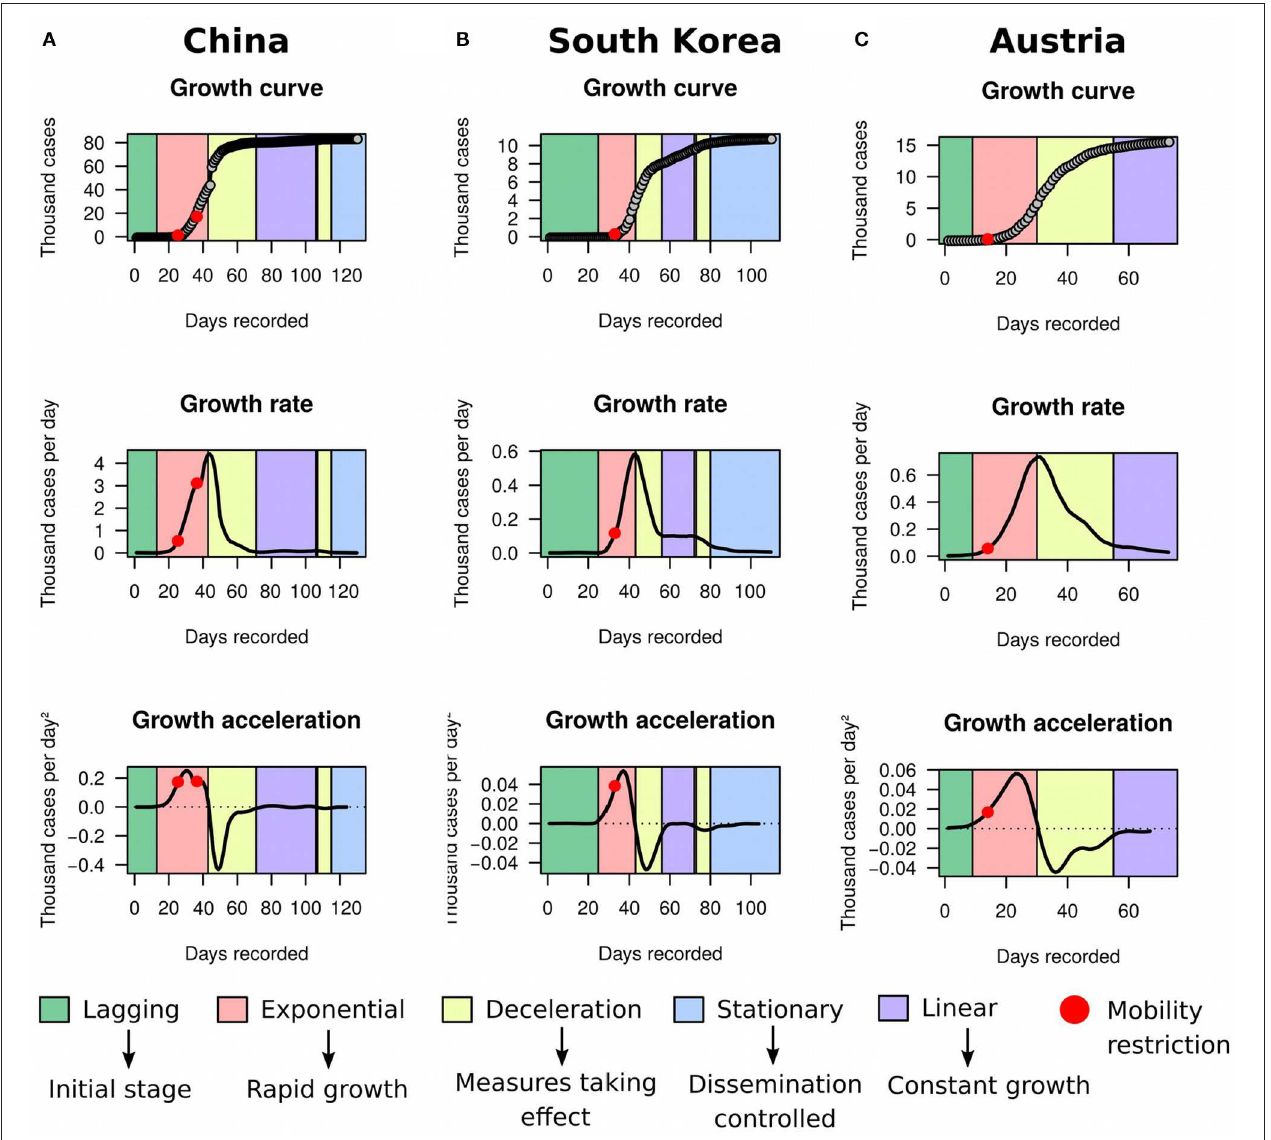
FIGURE 4 | Growth rate and acceleration in China, South Korea, and Austria. (A) Fitted curves for China between December 31st 2019 and May 8th 2020. The first red dot marks the midpoint between January 23rd and 24th 2020, when a strict cordon sanitaire was imposed to Wuhan, Shanghai, Jiangsu, and Hainan. The second red dot pinpoints February 4th 2020, when the cordon was extended to a larger portion of the eastern part of China. (B) Fitted curves for South Korea between January 20th and May 8th 2020. The red dot is placed between February 20th and 21st, when a collection of restrictions to human mobility was imposed, including lockdown of Daegu city, suspension of flights, cancellation of mass gatherings, and lockdown of all South Korean military bases. (C) Fitted curves for Austria between February 26th and May 8th 2020. The red dot is placed on March 10th, when the Austrian government ordered children to stay at home and announced closure of universities and cancellation of public gatherings. The apparent stationary phase in these three countries was in reality classified as a mixture of linear growth, deceleration, and stationary stage by our